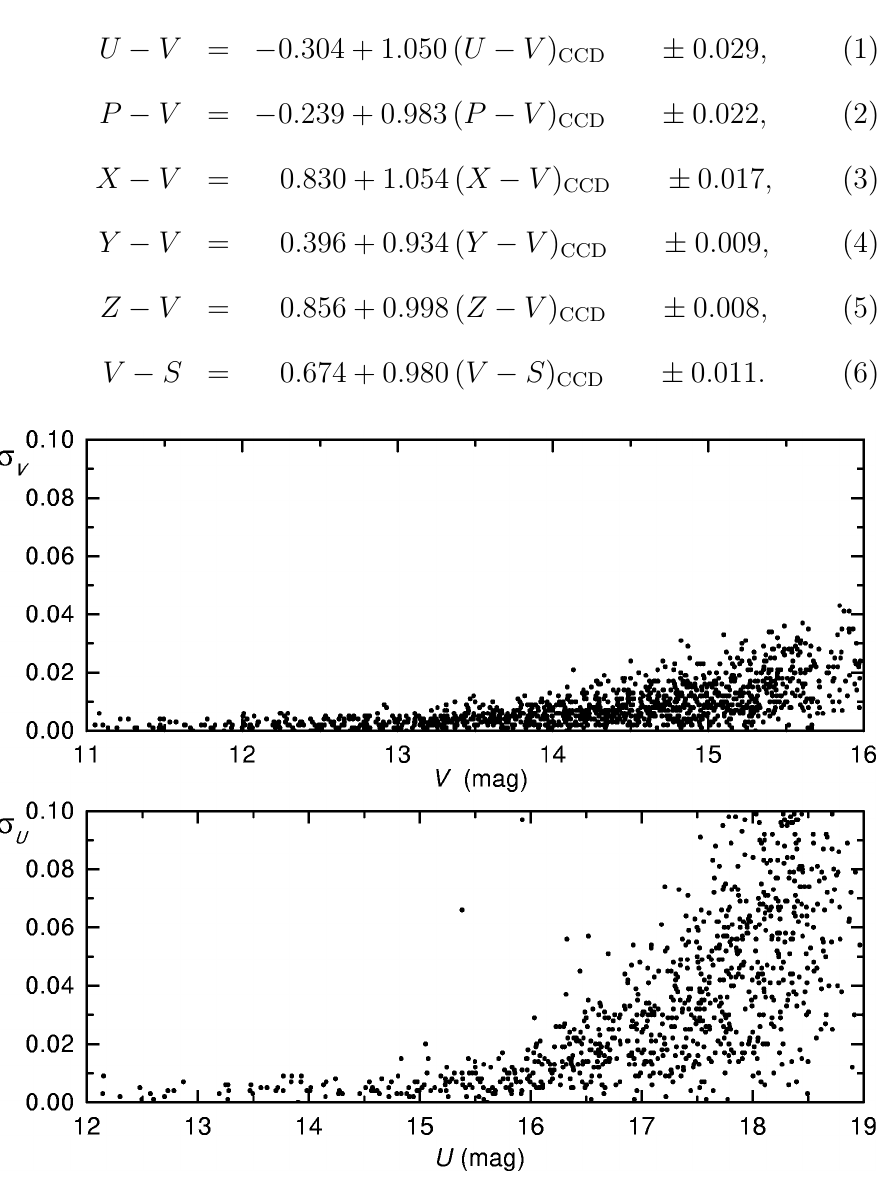
Fig. 4. The rms errors of the U and V magnitudes as a function of the star